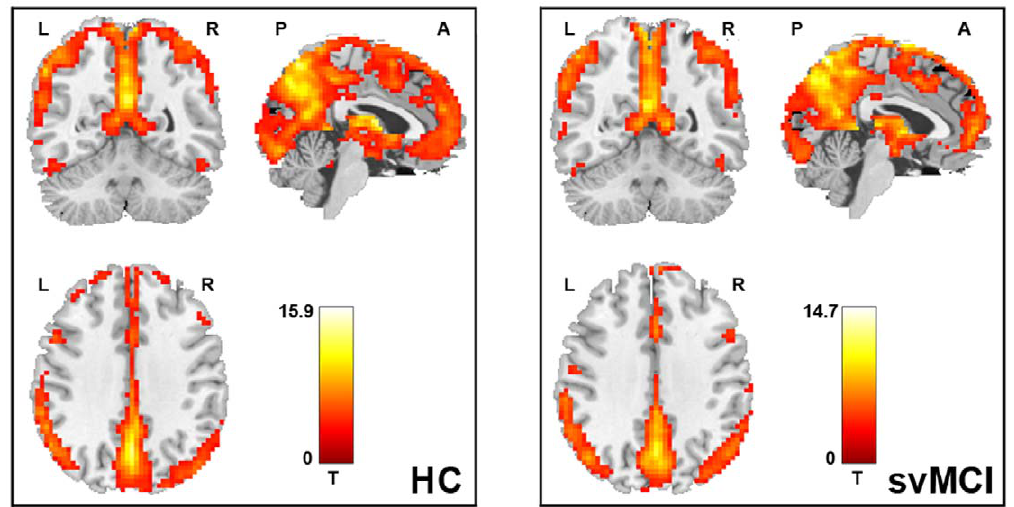
Figure 2. Within-group ALFF maps of the HC (left) and svMCI (right) groups. Widely spread regions of parietal, frontal, occipital and temporal lobes exhibited high ALFF values in the both groups. Note that the posterior cingulate (PCC) and adjacent precuneus (PCu) showed the highest ALFF values in the both groups. The statistical threshold was set at P , 0.001 for individual voxels and cluster size . 324 mm 3 , which corresponded to a corrected P , 0.01 determined by Monte Carlo simulations. L, left; R, right; P, posterior; A, anterior.